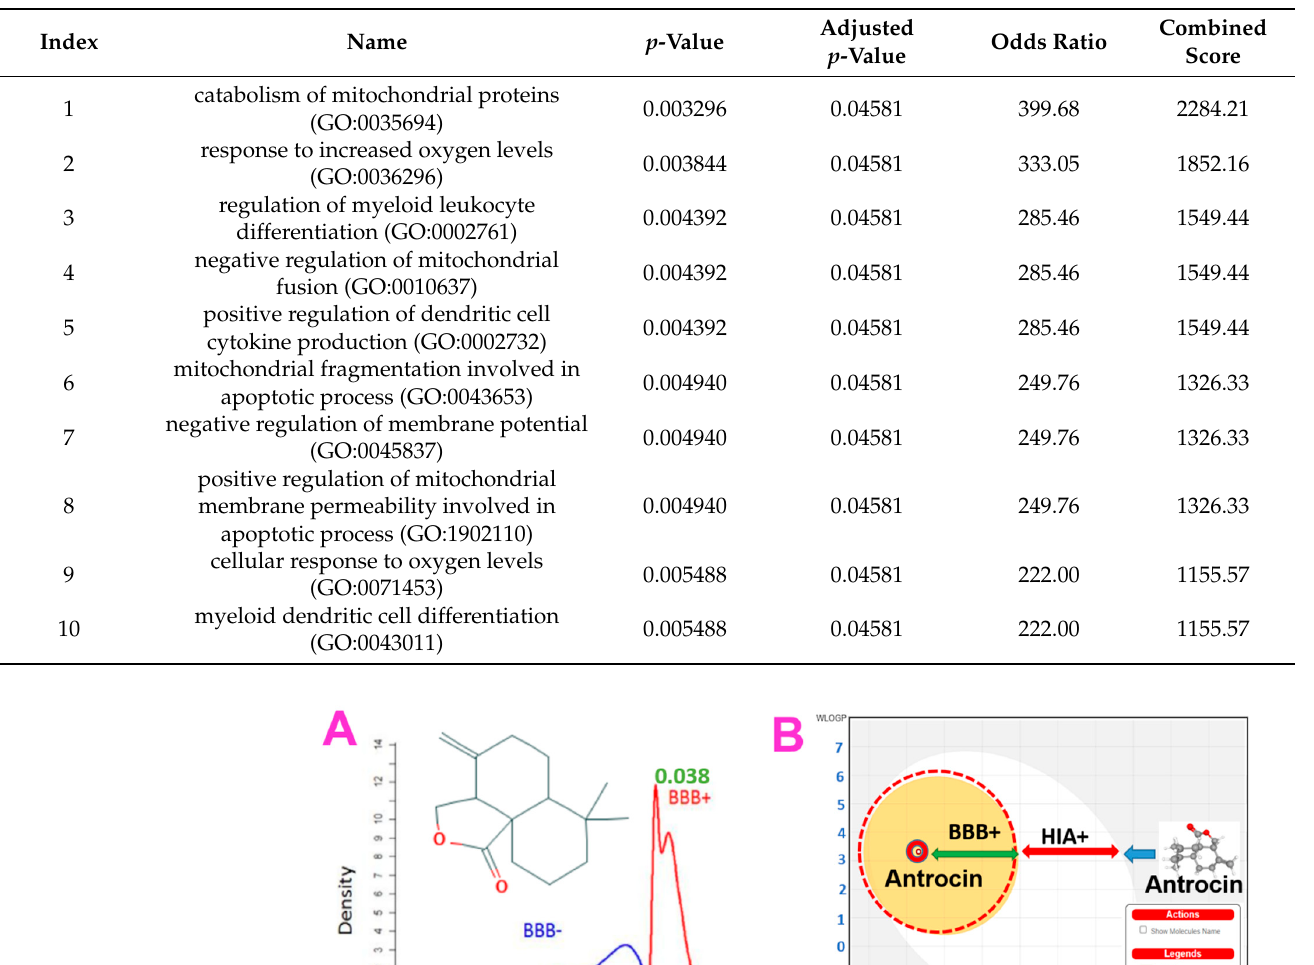
Table 3. Biological processes enriched by the target genes.